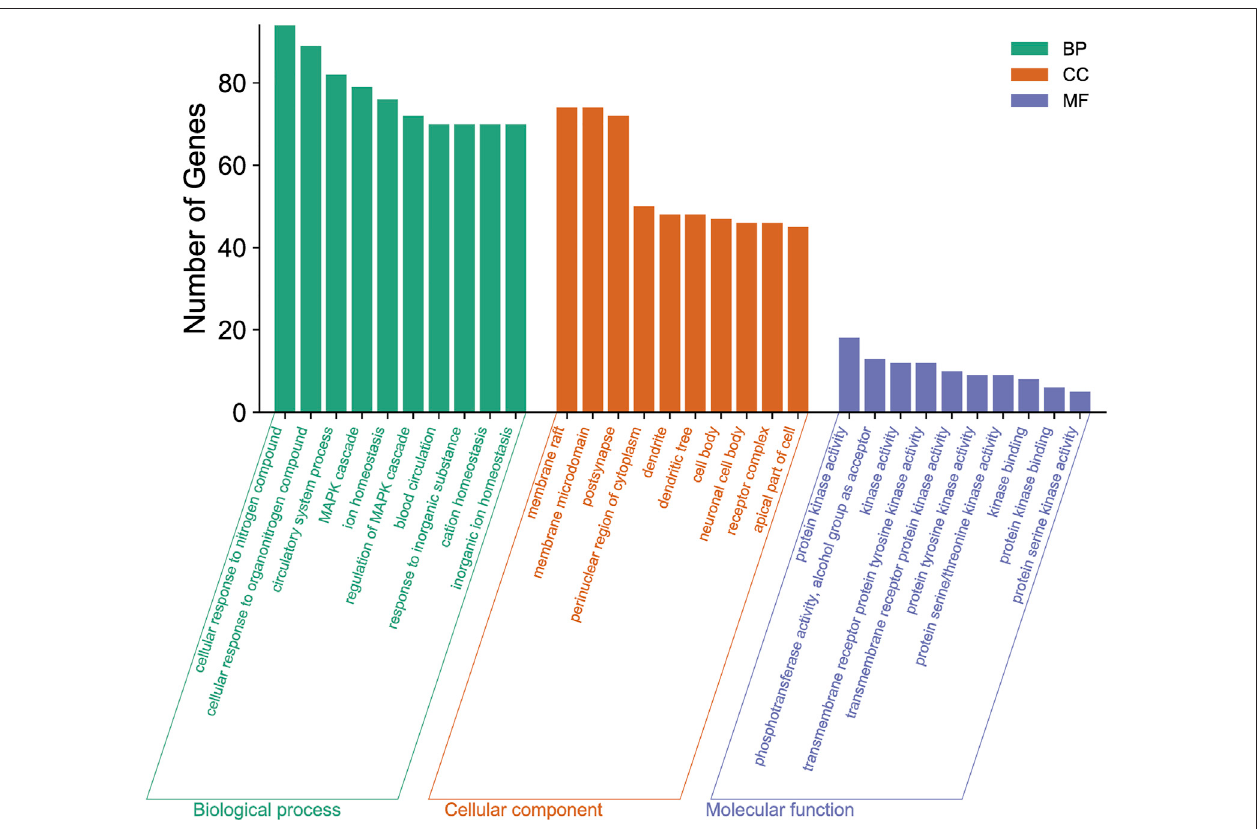
FIGURE4| GeneOntology(GO)enrichmentanalysisofthenewtreatmentformulationforischemicstrokewithQide fi ciencyandbloodstasissyndrome.Thetop10 biologicalprocesses, cellular components,and molecularfunctions areshown asabar chart. The x -axis representstheGOterms and the y -axis represents thenumber of annotated